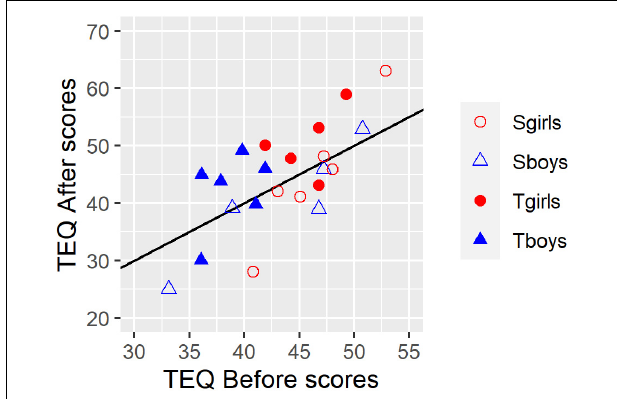
FIGURE 1 | Toronto Empathy Questionnaire Before and After scores for each of 22 participants. Symbols indicate subgroups. Filled symbols: Turn-taking. Open symbols: Synchrony. Red circles: girls. Blue triangles: boys. Datapoints with identical values are slightly offset on the x -axis so they can be seen. The solid black diagonal line shows x = y, i.e., a symbol appearing on this line indicates no change between Before and After Scores. Higher After than Before scores lie above the line, and lower ones lie below the line.